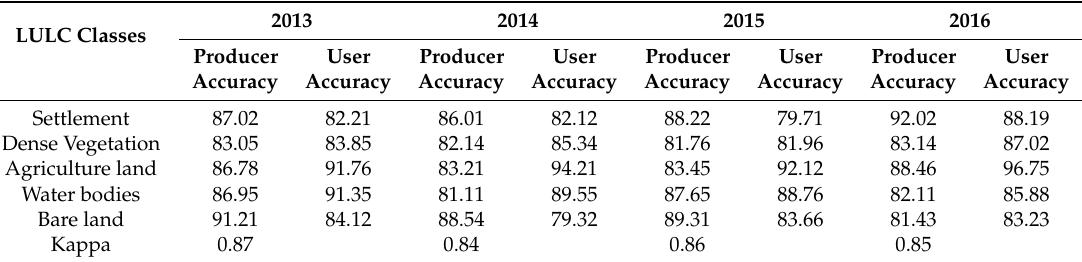
Figure 4. Classified land-use and landcover (LULC) maps of Kirchheller Heide in July 2013, 2014, 2015, and 2016. Table 2. Summary of the confusion matrix for the classified images of